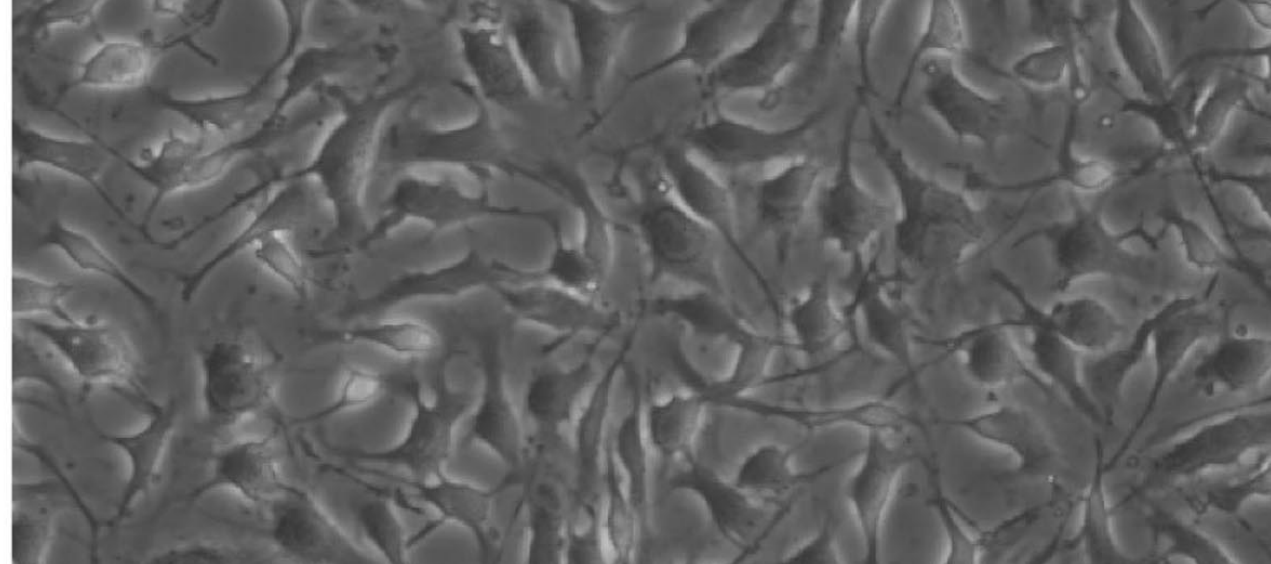
FIGURE 1 - Morphological changes induced by sunitinib. (A) Comparison of cellular morphology between parental cells HMEC- 1 and sunitinib-resistant cells HMEC-su at 12 months. (B) Morphological changes of HMEC-su cells compared with HMEC-1 cells at indicated time points. ×200, Arrow indicates vacuole. Scale bar: 200